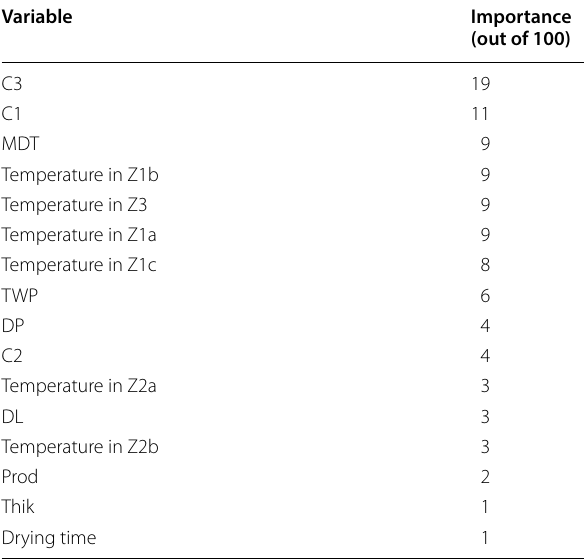
Table 2 Variable importance in the fitted regression tree of temperature of